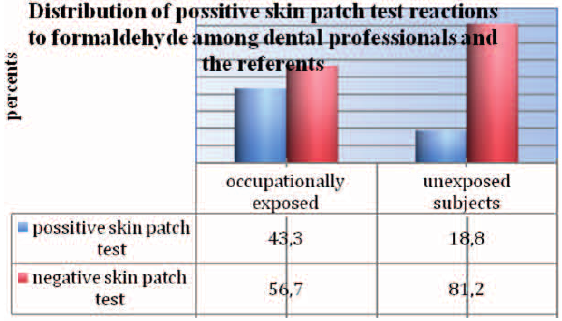
Figure 1. Distribution of positive skin test reactions to formaldehyde (in %) among the dental professionals and the referents (* p =